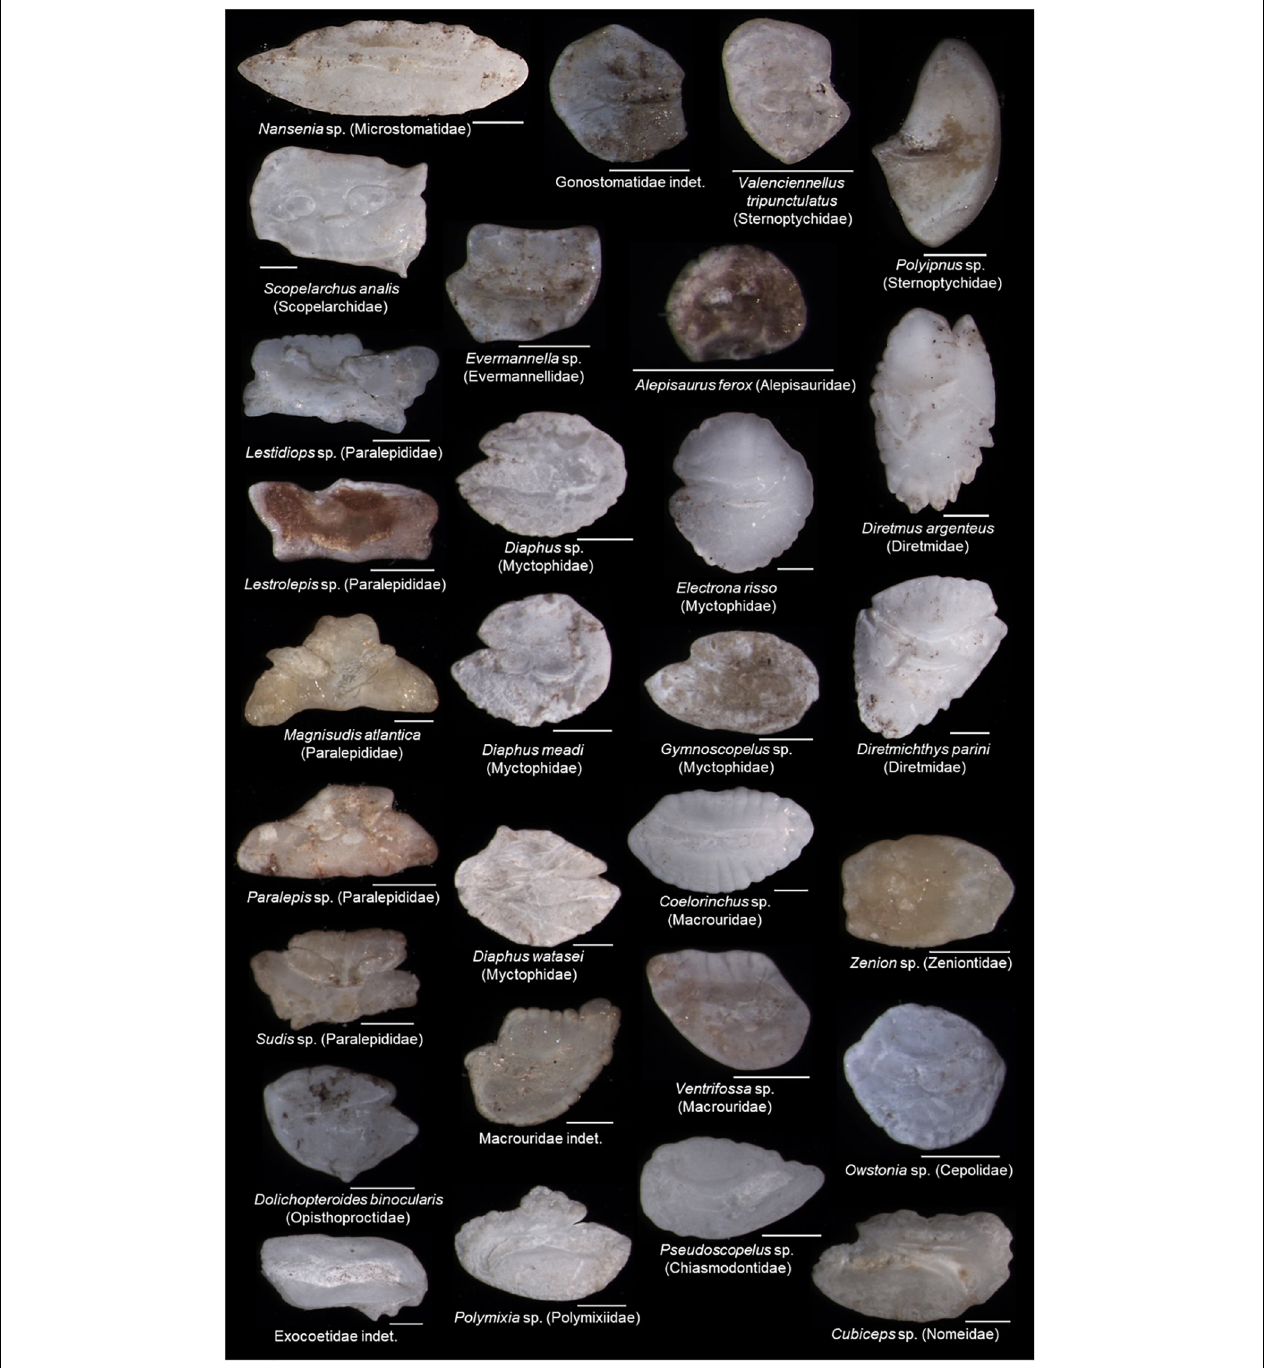
FIGURE 2 | Otoliths recovered from stomach contents of the bigeye tuna ( Thunnus obesus ). Scale bar = 1